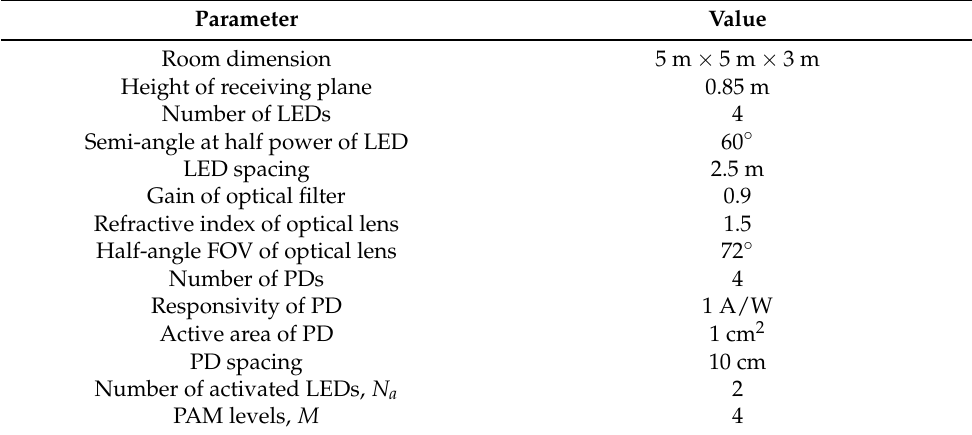
Table 1. Simulation parameters.